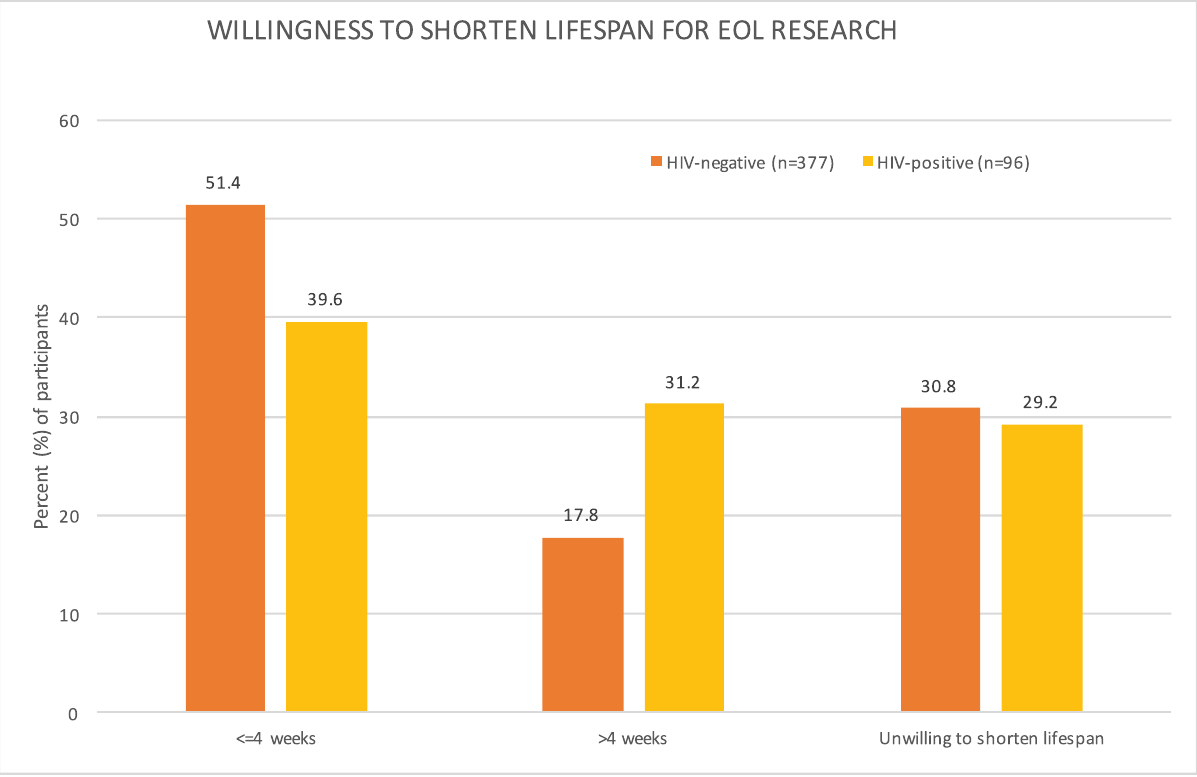
Fig 1. Willingness to shorten lifespan for end of life research. Our surveys found that 69.2% ( n = 68) of HIV-positive and 70.8% ( n = 261) of HIV- negative participants were willing to shorten their lifespans for the sake of end of life research. A higher proportion (31.2%) of the HIV-positive group was willing to donate > 4 weeks of their lives. About a third of respondents in both groups stated that they were unwilling to shorten their lifespans for the sake of research.